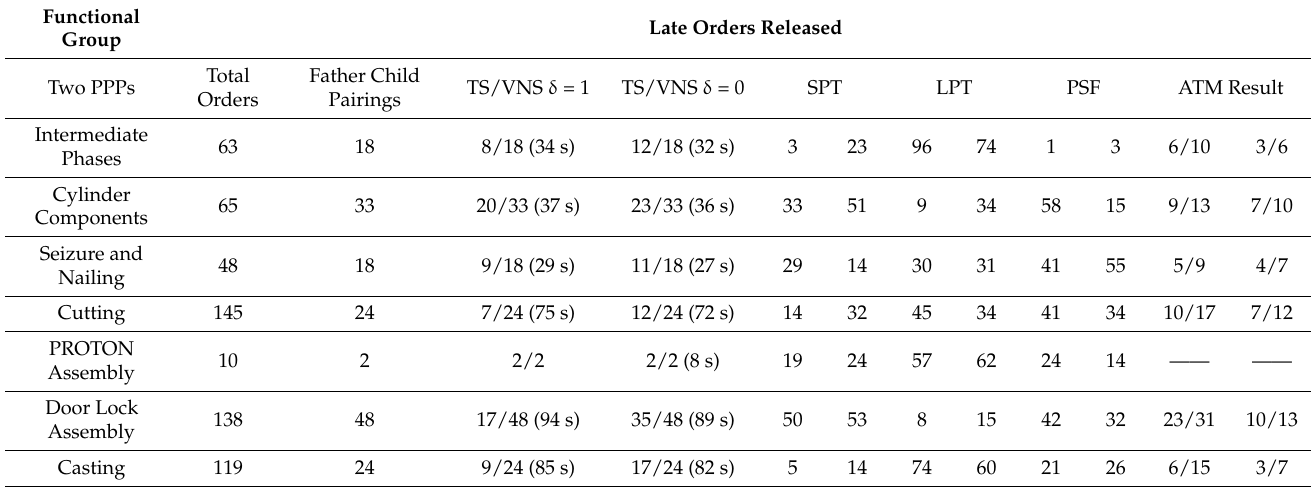
Table 7. Results of TS/VNS-ATM with late orders released.